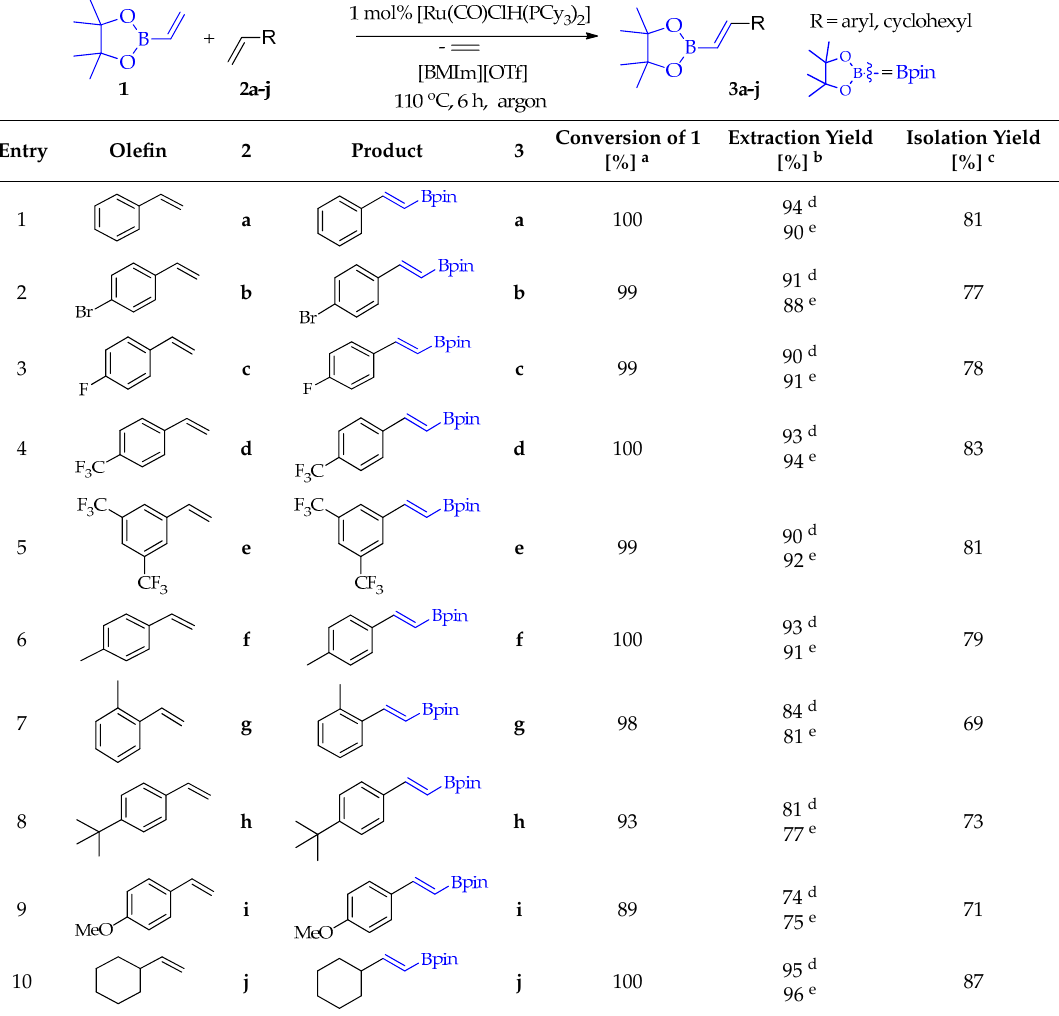
Table 4. Borylative coupling of 1 with a various olefins 2a – j in Ru(CO)Cl(H)(PCy 3 ) 2 @[BMIm][OTf] in optimized reaction and extraction conditions.